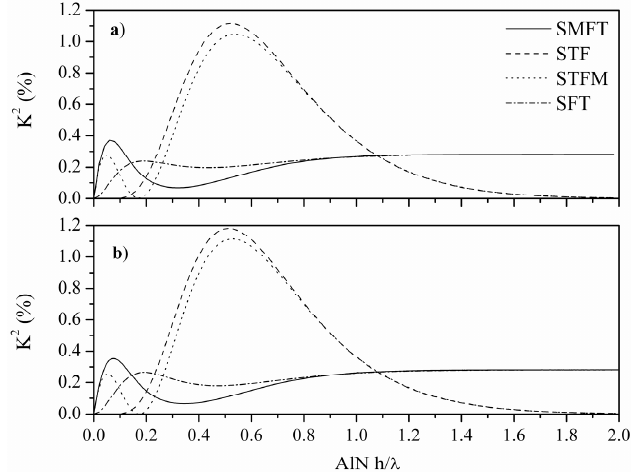
Figure 13. The K 2 dispersion curves of the Rayleigh-like waves propagating along the <100> ( a ) and <110> ( b ) directions of the four 3C-SiC(001)/AlN-based coupling configurations.